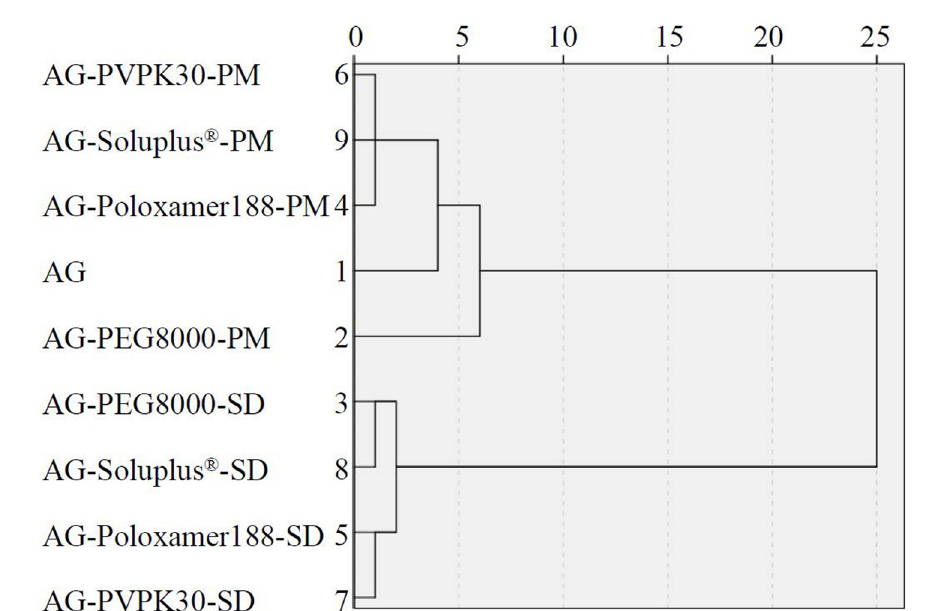
FIGURE 8 - Cluster analysis tree diagram by intergroup connection on the variable of the dissolution percentage at different